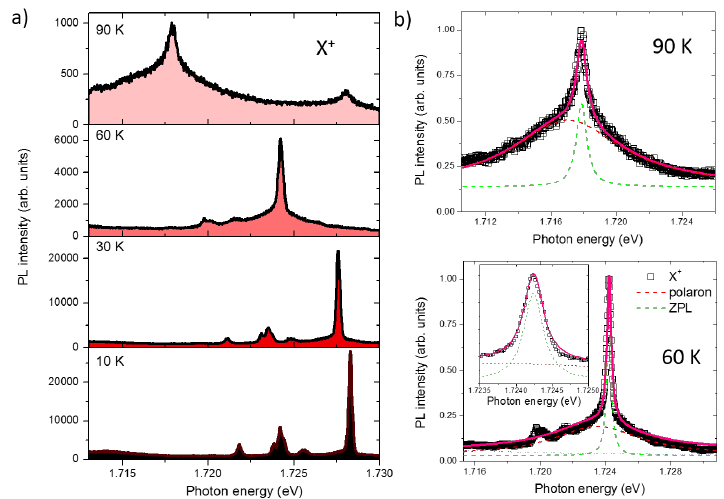
Figure 4. ( a ) Selected PL spectra from 10 to 90 K of a single QD with a bright X + emission. ( b ) Bottom panel: detail of the spectrum from A at 60 K with Lorentzian fits of the zero phonon line and the polaron band. The inset shows a blow up of the zero phonon line (ZPL). Top panel: detail of the spectrum at 90 K with Lorentzian fits. The measurements have been performed exciting with a laser power of 7000 nW.